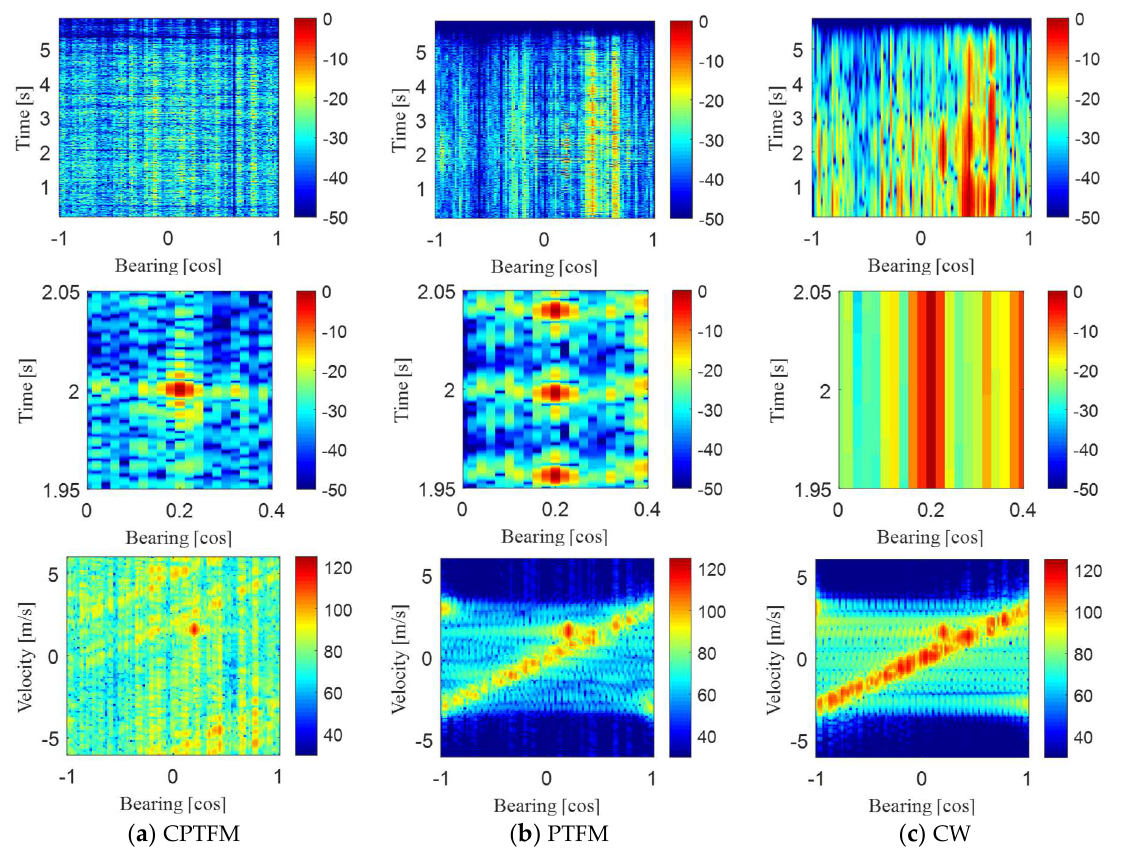
Figure 8. Time−bearing diagram and velocity-bearing diagram in zones A and B for CPTFM, PTFM Figure 8. Time–bearing diagram and velocity-bearing diagram in zones A and B for CPTFM, PTFM and CW waveforms. The top row is a time−bearing diagram of different waveforms, the middle row and CW waveforms. The top row is a time–bearing diagram of different waveforms, the middle row is a zoomed-in time−bearing diagram around the target, and the bottom row is a velocity−bearing is a zoomed-in time–bearing diagram around the target, and the bottom row is a velocity–bearing diagram of different waveforms. diagram of different waveforms.